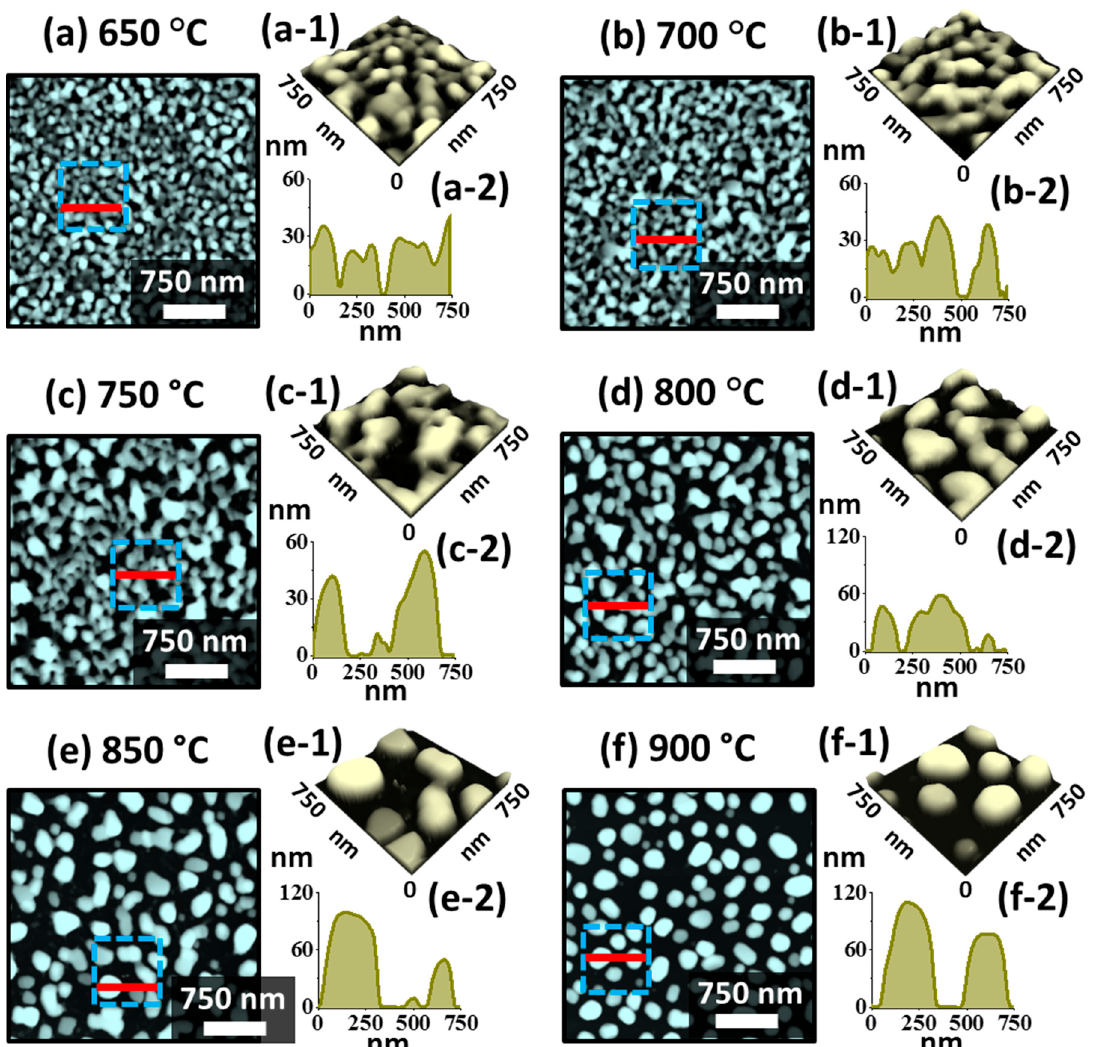
Figure 5. Evolution of medium size and isolated Pt NPs with the In 45 nm / Pt 15 nm bilayers annealed between 650 and 900 ◦ C for 450 s. ( a )–( f ) AFM top-views of 3 × 3 µ m 2 . ( a-1 )–( f-1 ) Magnified side-views (750 × 750 nm 2 ) of corresponding Pt nanostructures (boxed regions in the AFM top-views). ( a-2 )–( f-2 ) Cross-sectional line-profiles of the regions marked with the red lines in ( a )–( f ).